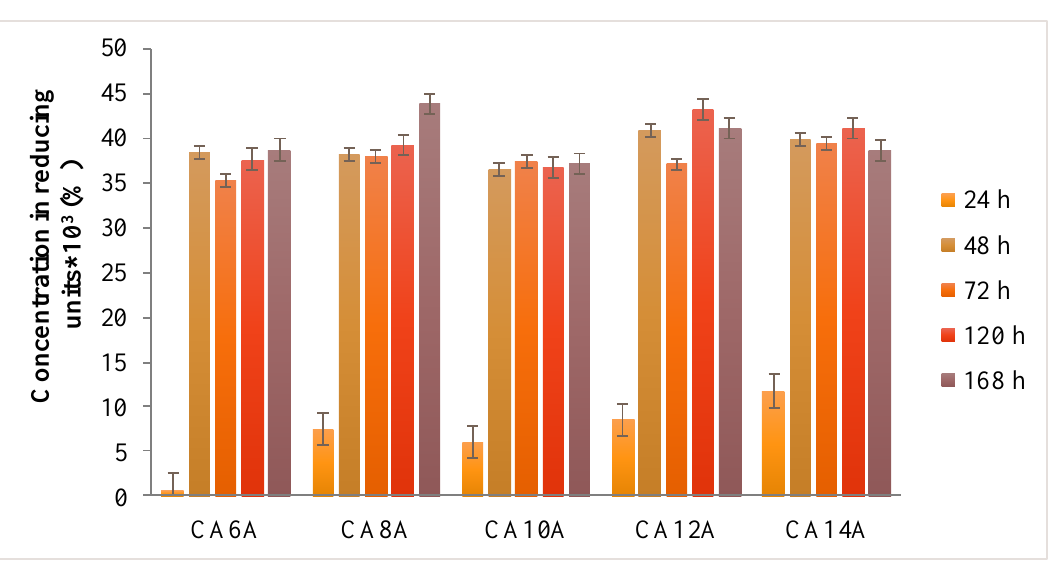
Figure 7. Degradation behavior of hydrogels in medium with enzyme.